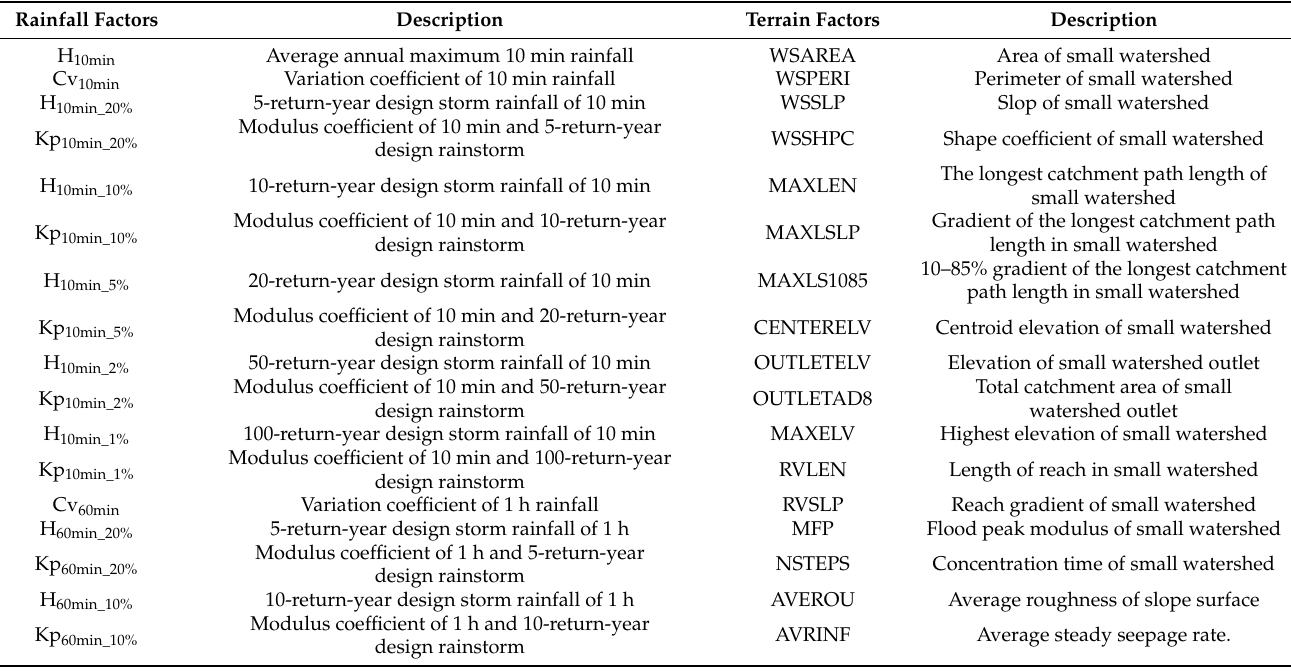
Table 2. Attributes of Rainfall and Terrain in Small